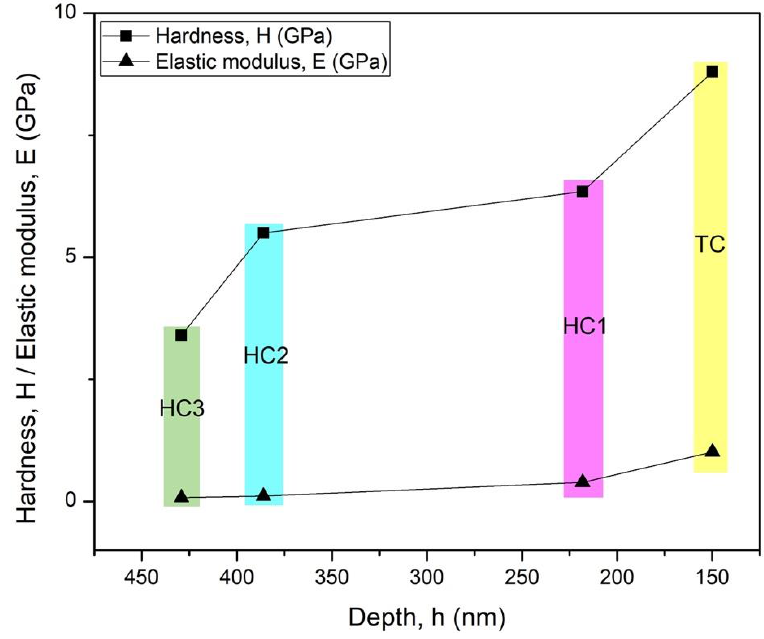
Figure 6. The mechanical properties of coatings, H and E, versus penetration depth.